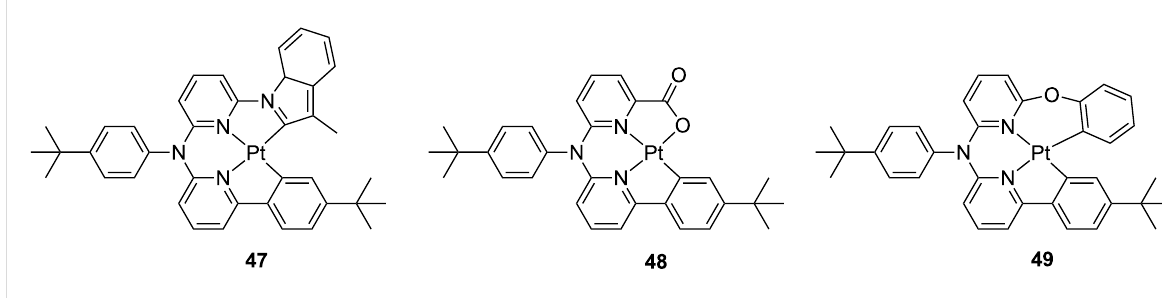
Figure 20: Molecular structure of asymmetric derivatives 47 – 49 based on triaryl-type of bridge [90].